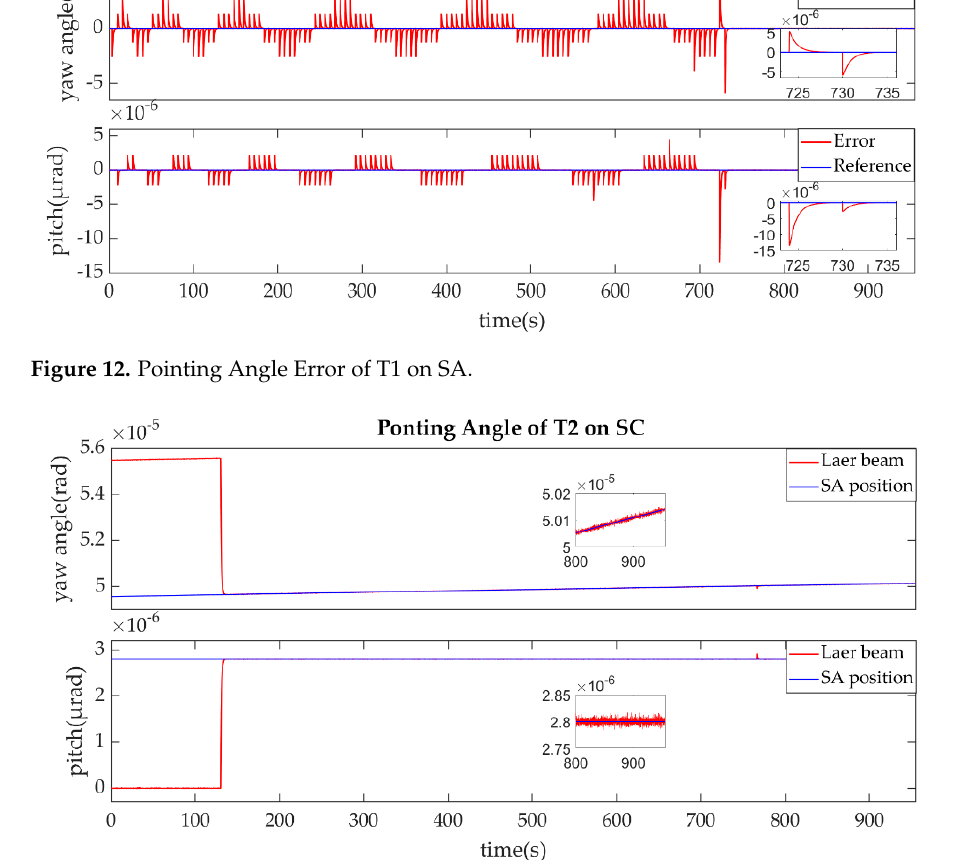
Figure 13. Pointing Angle of T2 on